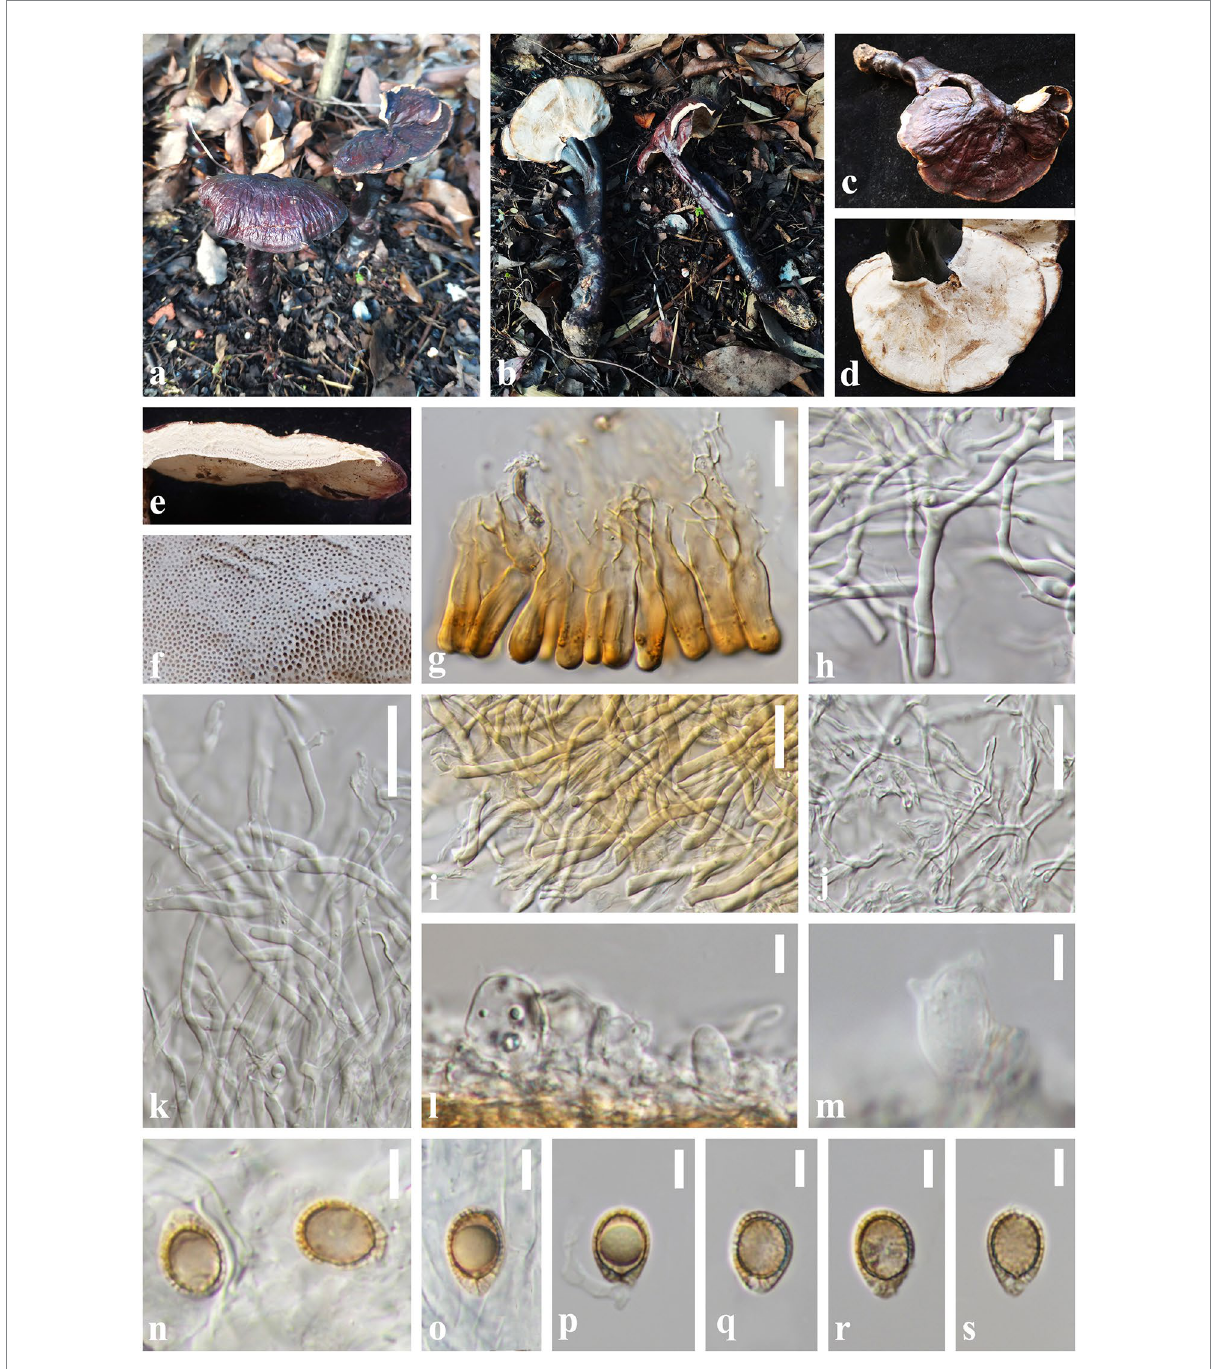
FIGURE 6 Ganoderma yunnanense (HKAS 123771, holotype) (A,B) Basidiomata. (C) Upper surface. (D) Lower surface. (E) Transverse section of pileus. (F) Pore surface. (G) Sections of pileipellis. (H,I) Skeletal hyphae from context. (J) Binding hyphae from context. (K) Generative hyphae from tubes. (L,M) Basidia and basidioles. (N–S) Basidiospores. Scale bars: (I–K) = 20 μ m, (G,H) = 10 μ m, (L–S) = 5 μ m. Photographs were taken by